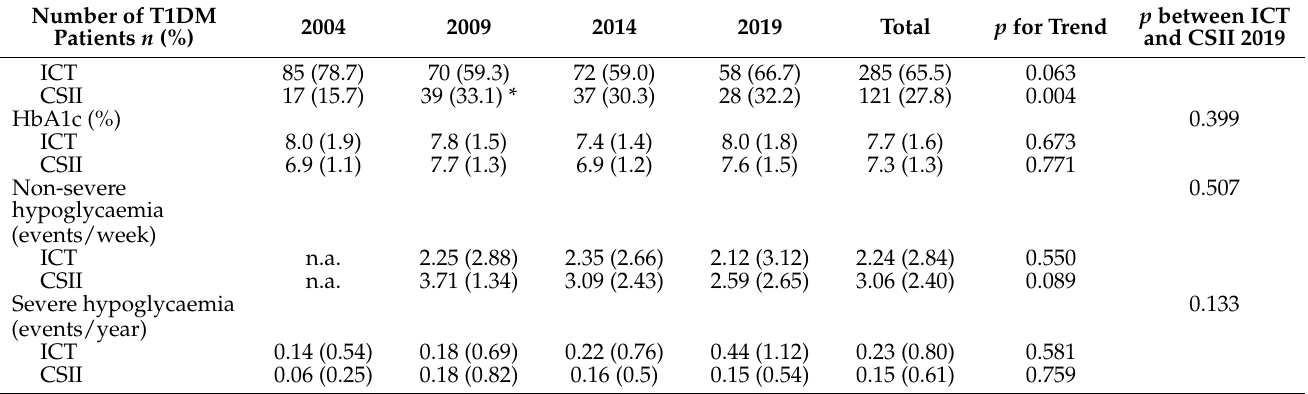
Table 8. Comparison between T1DM patients treated with ICT or CSII in tertiary